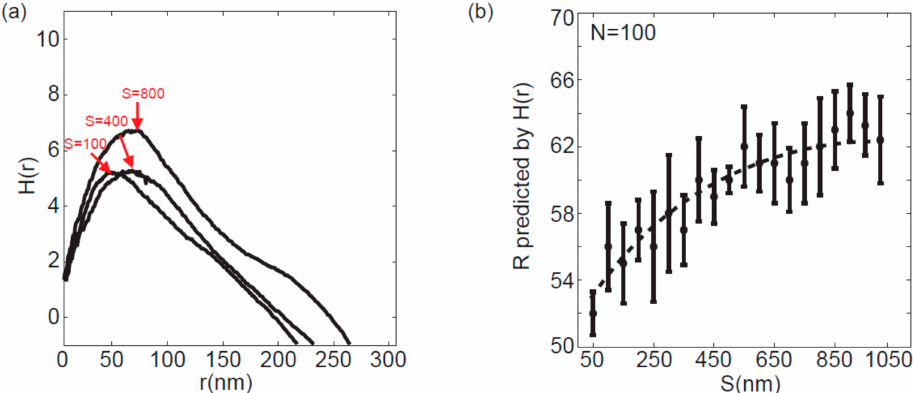
Figure 2. ( a ) Peak analysis results for three modeled single molecule localization microscopy (SMLM) images containing 10 randomly distributed clusters of set radius R set average distances of cluster separations (100 nm, 400 nm and 800 nm). ( b ) The cluster radius predicted by peak analysis as a function of the cluster separation, the ± SD represents the standard derivation of peak analysis for 100 independent point distributions for each cluster